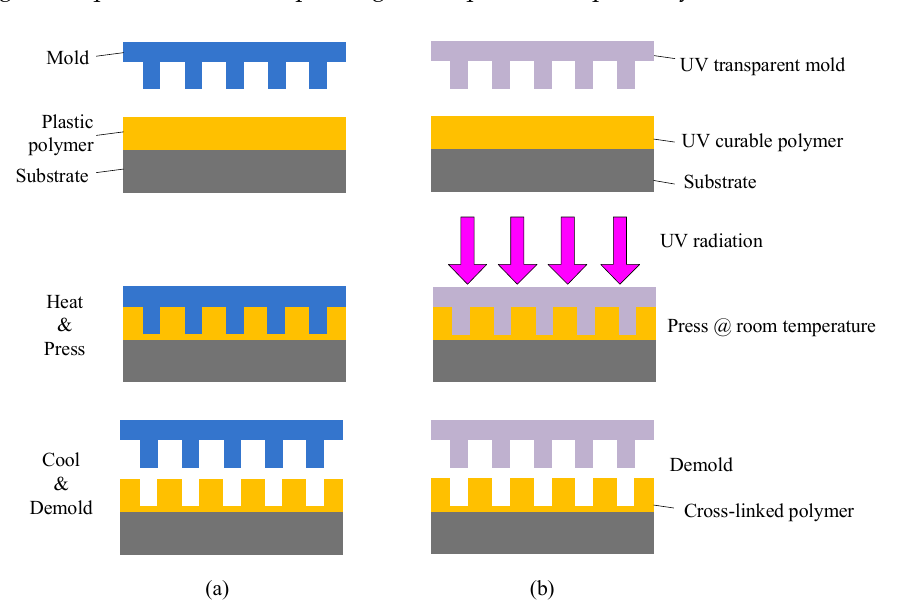
Figure 1. Schematic of fabrication process: ( a ) thermal imprinting and ( b ) UV imprinting.